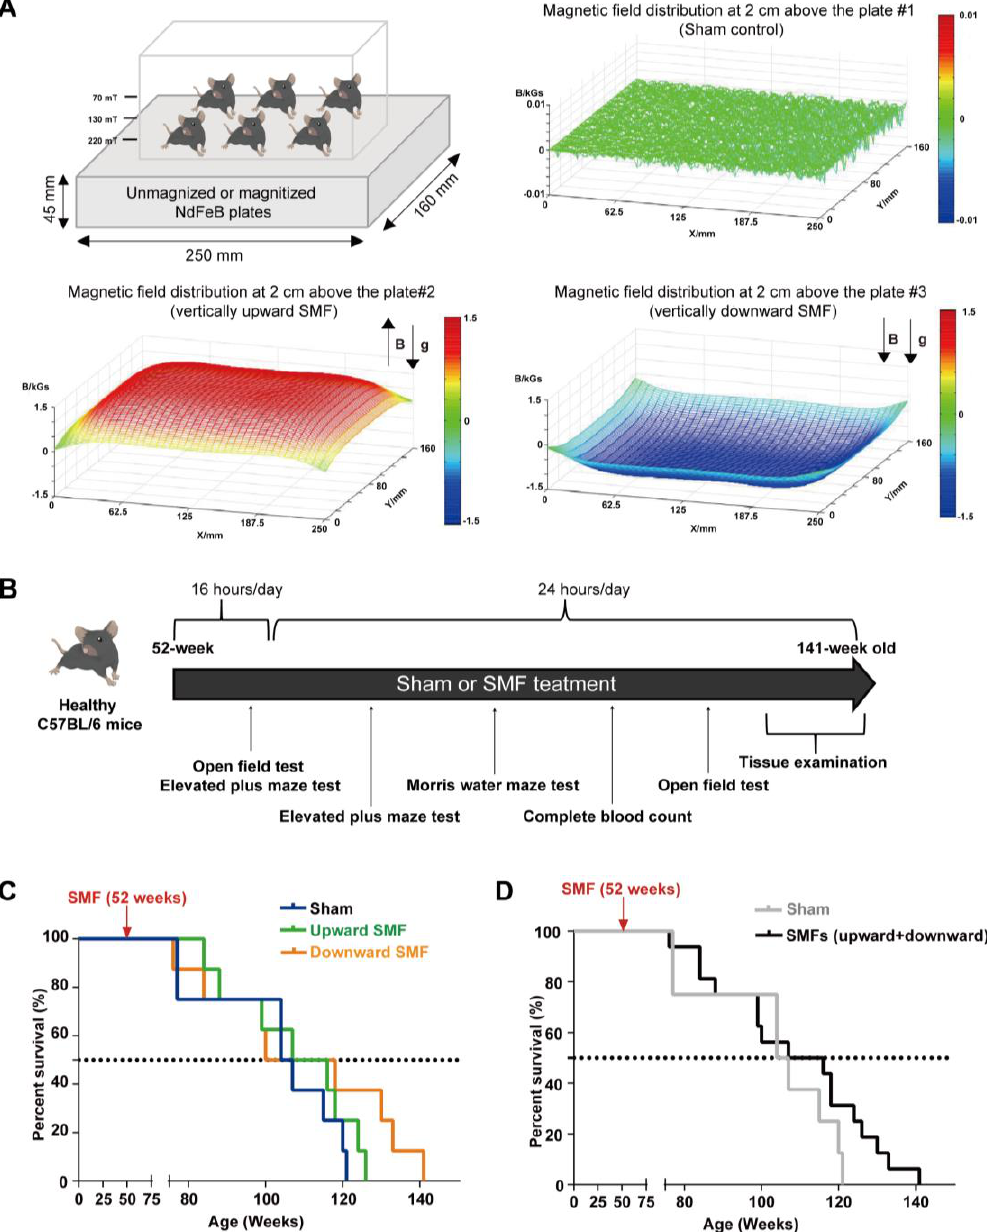
Figure 1. Moderate quasi–uniform SMF long–term exposure prolongs mice lifespan. ( A ) A diagram of the mice cage placed on sham control vs. two different magnetic plates that provide vertically upward and downward direction SMFs. Magnetic flux densities were scanned at 2 cm above the plates; ( B ) experimental design flow chart; ( C , D ) the survival rate of naturally aged mice. The survival rate recorded for naturally aged mice in vertically upward or downward SMF exposure groups was analyzed separately ( C ) or grouped together as SMFs ( D ). n = 8 mice for the sham control, upward SMF or downward SMF group in the beginning of the experiment.